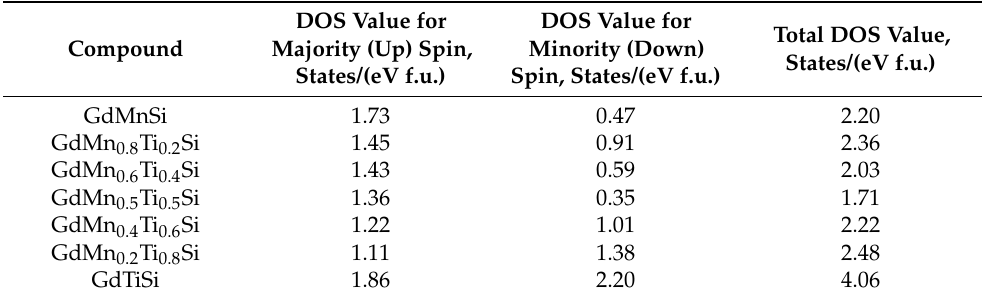
Table 2. The values of the total and partial spin densities of electronic states at the Fermi energy in GdMn 1- x Ti x Si for x = 0–1.